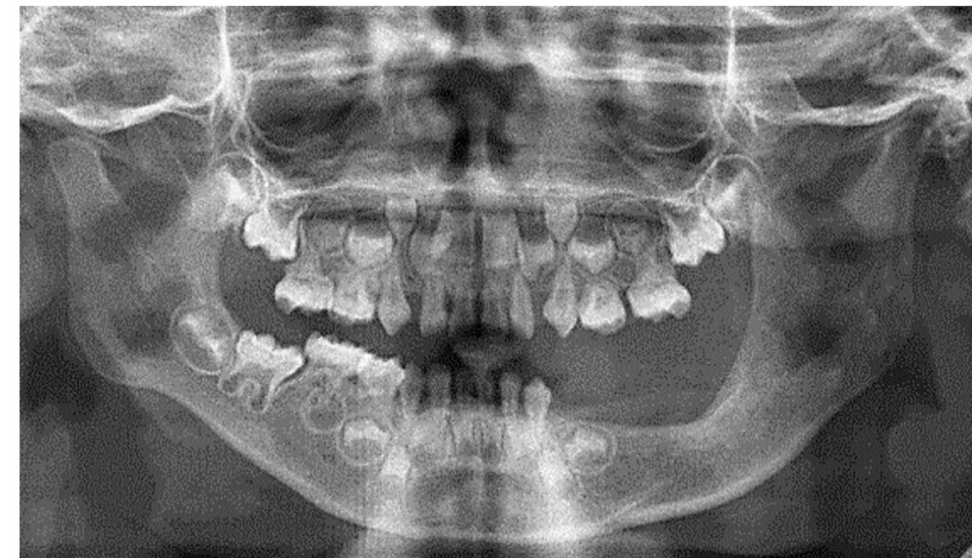
Figure 9. 15-month postoperative Rx orthopantomography showing excellent bone tissue regenera- tion at the surgical site. Bone remodeling resulted in acceptable mandibular symmetry. The patient has been disease-free for two years as of today (Figure 10) and she is continuing her follow-up at the referral center for